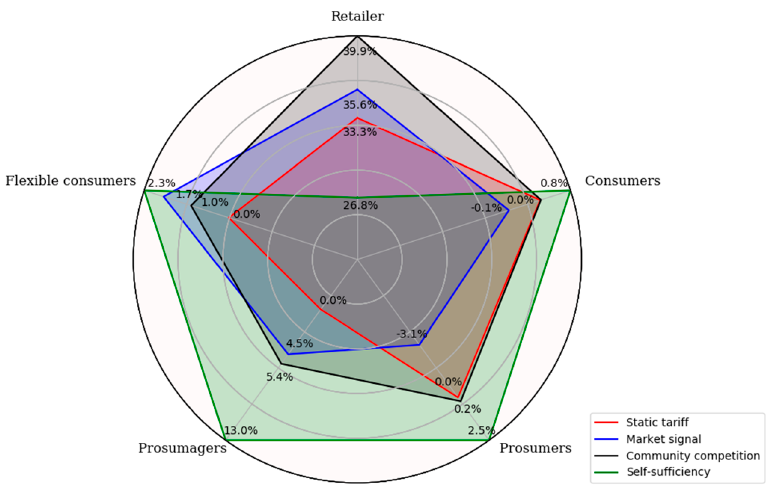
Figure 8. Actor’s utilities relative to BAU scenario. A positive value indicates an increase in the net income, negative values represent a decrease in net income.